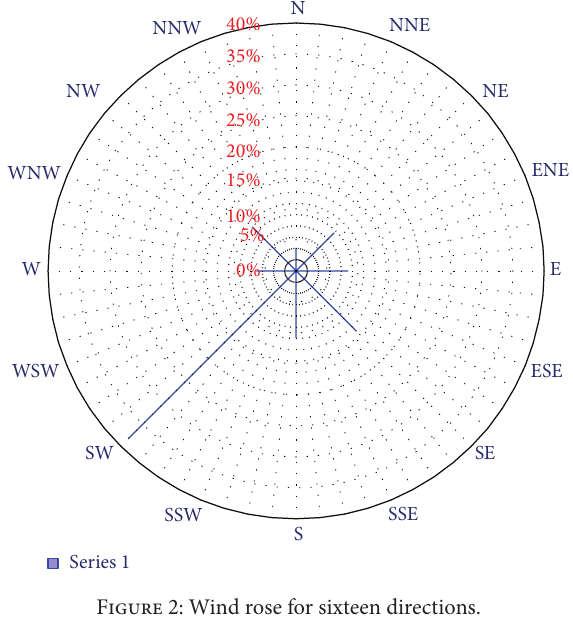
Figure 2: Wind rose for sixteen directions.